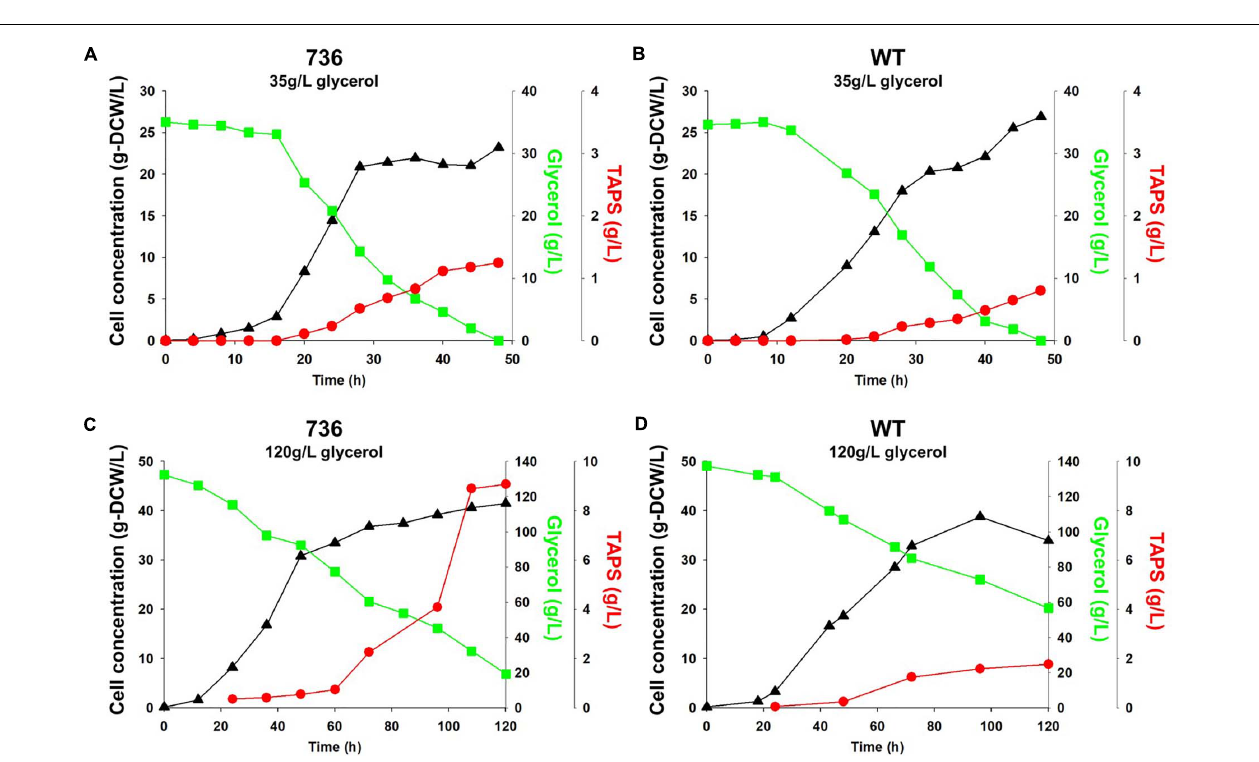
FIGURE 5 | Growth and TAPS titers of mutant 736 and the wild-type in batch fermentation procedures with 35 and 130 g/L of glycerol as a carbon source. Mutant 736 (A) and the wild-type (B) in the YMgISC medium supplemented with 35 g/L of glycerol as a carbon source. Mutant 736 (C) and the wild-type (D) in the YMgISC medium supplemented with 130 g/L of glycerol as a carbon source. Symbol (cid:49) represents cell concentration; (cid:3) , glycerol; • ,